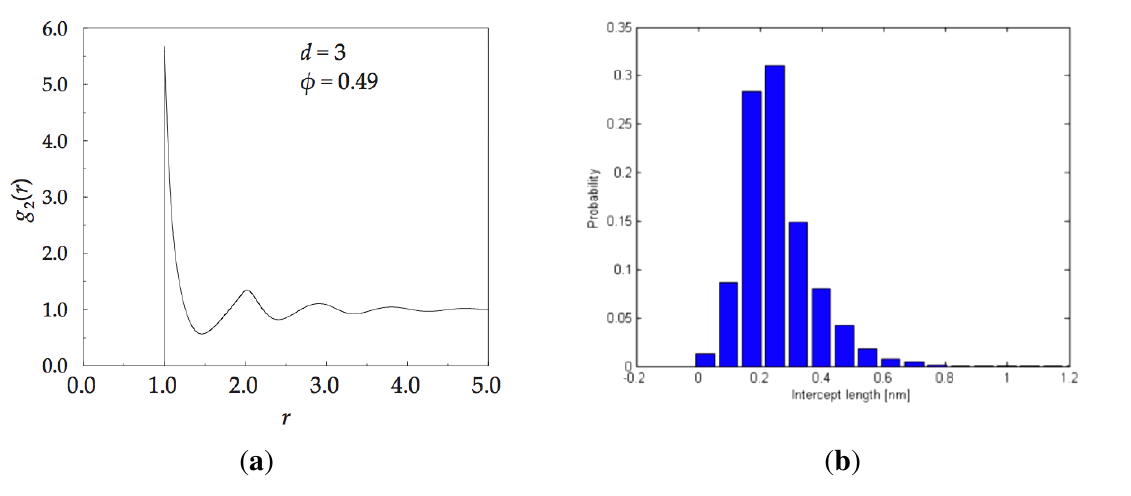
Figure 16. On left, pair distribution function for an monoatomic IAS. On right, statistics of the distribution of distances between atoms in a monoatomic ISA projected onto an arbitrarily chosen straight line regardless of the chosen direction of the